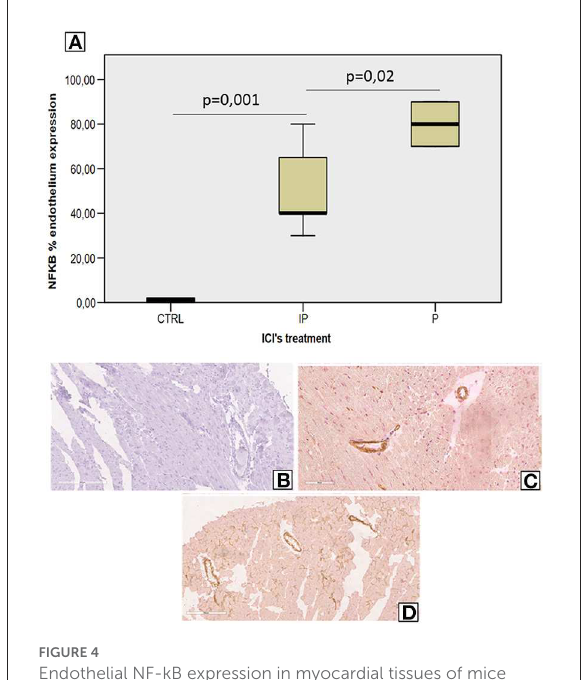
FIGURE4 Endothelial NF-kB expression in myocardial tissues of mice treated with ICIs (A ) Quantitative analysis of NF-kB endothelial expression (%) in mice untreated or treated with ICIs ( n = 6). Vascular expression of NF-kB in mice untreated (B) or treated with Ipilimumab (C) or Pembrolizumab (D)